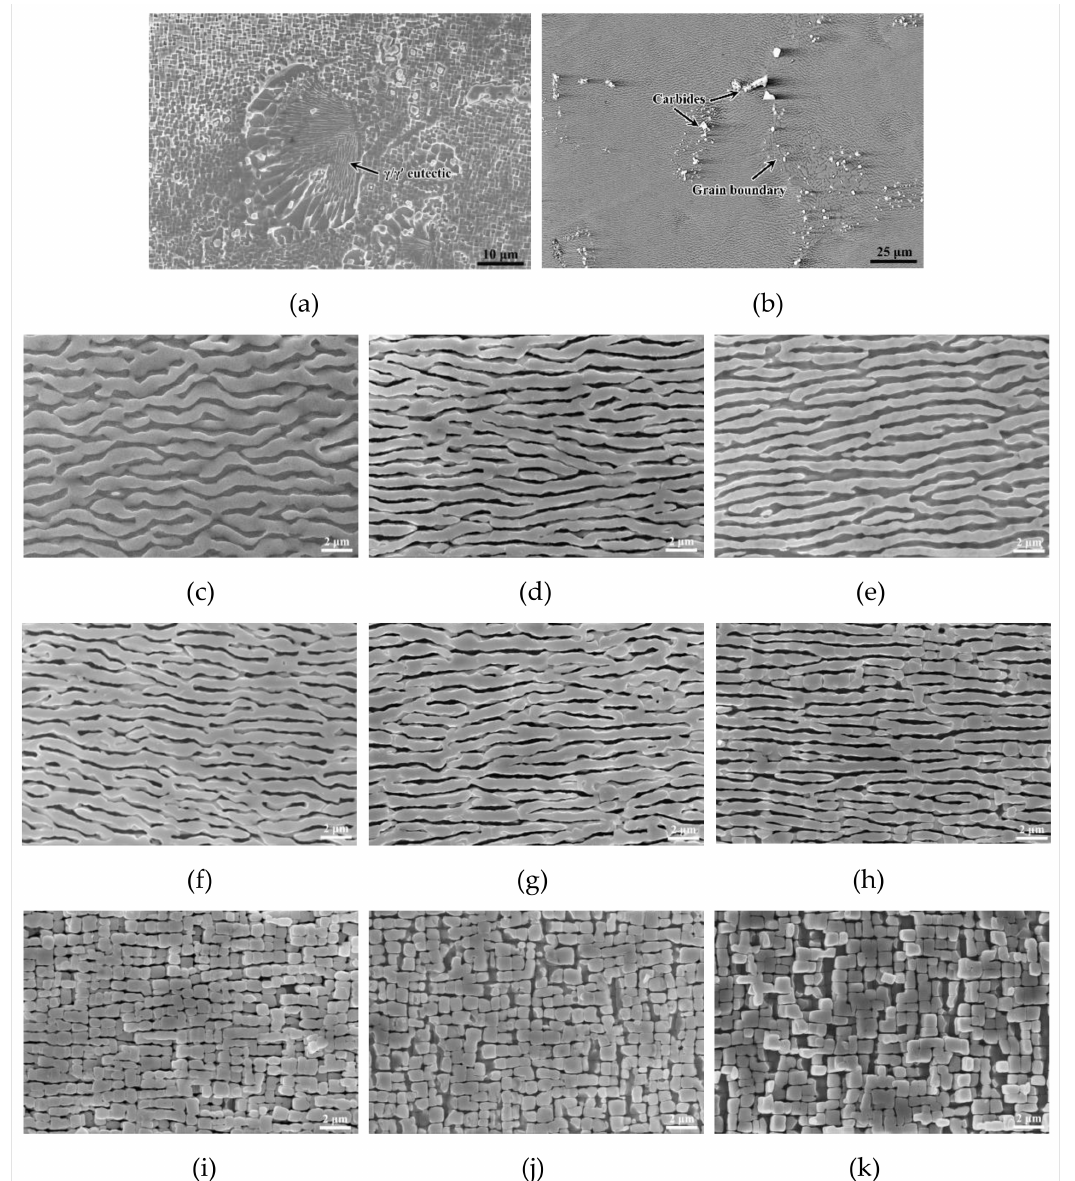
Figure 2. Microstructure morphologies after different simulated experiments: scanning electron microscopy back-scattered electron (SEM-BSE) images of the γ / γ ’ eutectic ( a ) and carbides in the in- terdendritic regions ( b ) under 1020 ◦ C/150 MPa; SEM-SE images of the γ ’ precipitates in the dendrite cores along longitudinal sections under 1020 ◦ C/150 MPa ( c ), 1020 ◦ C/100 MPa ( d ), 1020 ◦ C/70 MPa ( e ), 980 ◦ C/180 MPa ( f ), 980 ◦ C/110 MPa ( g ), 980 ◦ C/70 MPa ( h ), 880 ◦ C/220 MPa ( i ), 880 ◦ C/130 MPa ( j ), 880 ◦ C/70 MPa ( k